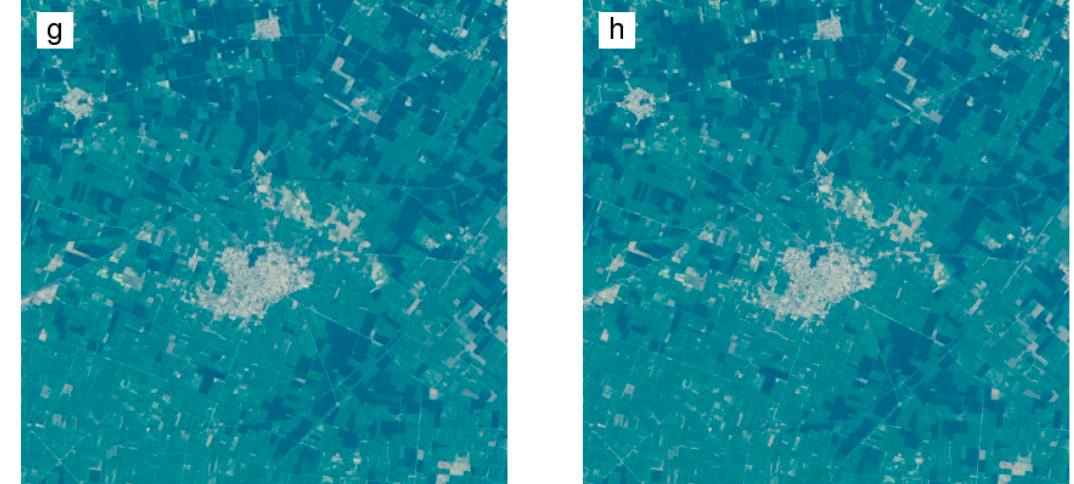
Figure 8. India illustrative 400 × 400 (15 m) subset. Top row: 15 m TOA panchromatic reflectance ( a ) and 30 m true color (red, green and blue) TOA reflectance cubic convolution resampled to 15 m ( b ); The following rows show 15 m true color Brovey (left column) and context adaptive Gramm-Schmidt (right column) pansharpened reflectance respectively, derived using intensity images computed using the equal ( c , d ); spectral response function based (SRFB) ( e , f ); and image specific spectral weights ( g , h ) summarized in the Figure 5 caption.